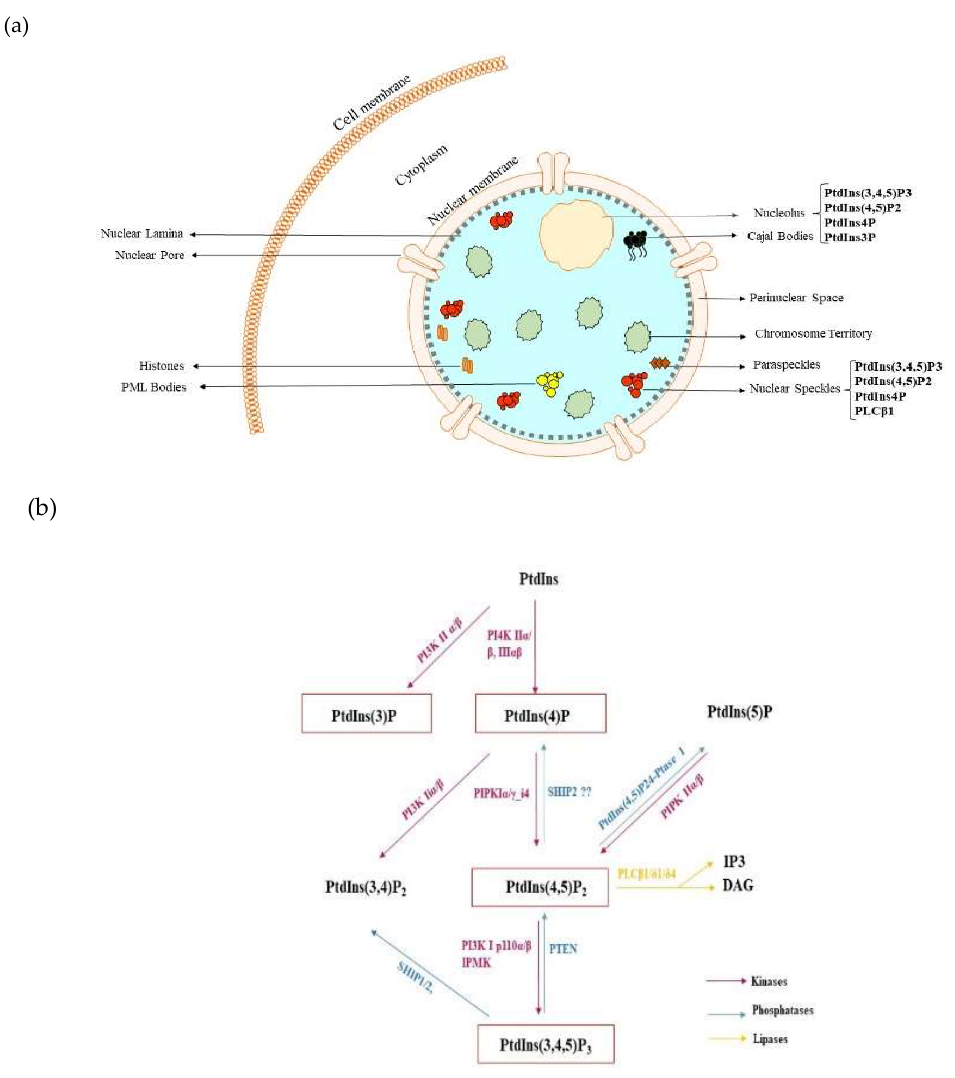
Figure 2. Nuclear subcompartments and nuclear inositide signaling. ( a ) A cartoon representation of the mammalian nucleus and some of its identified membraneless subcompartmental domains. Numerous inositides localize within these domains in the nucleus, while regulating gene expression, i.e., speckles; ( b ) Schematic representation of nuclear phosphoinositide (PI) signaling involving nuclear PIs and their nuclear metabolic enzymes.